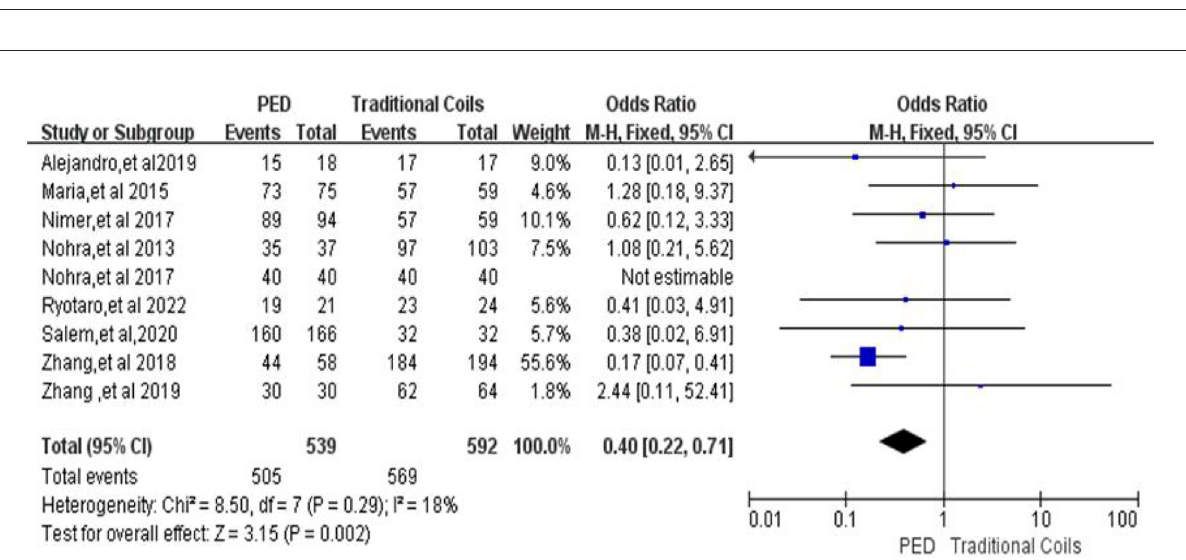
FIGURE5 Forest plot and meta-analysis of aneurysm retreatment rate.